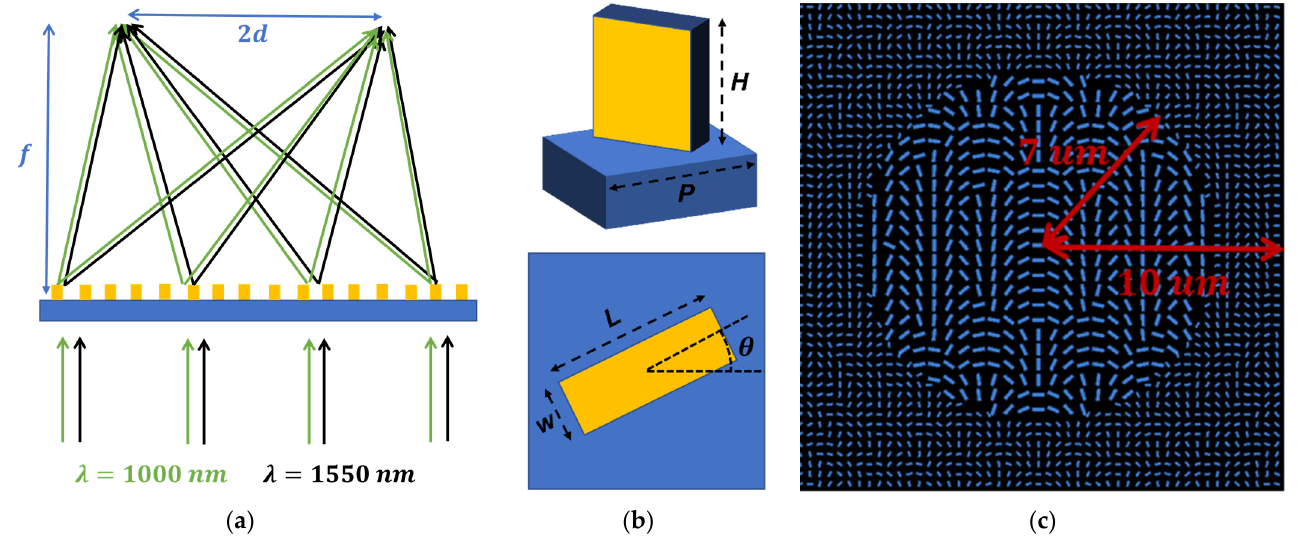
Figure 1. ( a ) Schematic illustration of the designed dual-wavelength achromatic polarization-dependent bifocal metalens. Transmitted light with the wavelengths of 1000 and 1550 nm can be both focused into the same focal plane transversely. ( b ) Unit cell with a Silicon nanobrick patterned on the glass substrate. ( c ) Spatial distribution of two different unit cells.